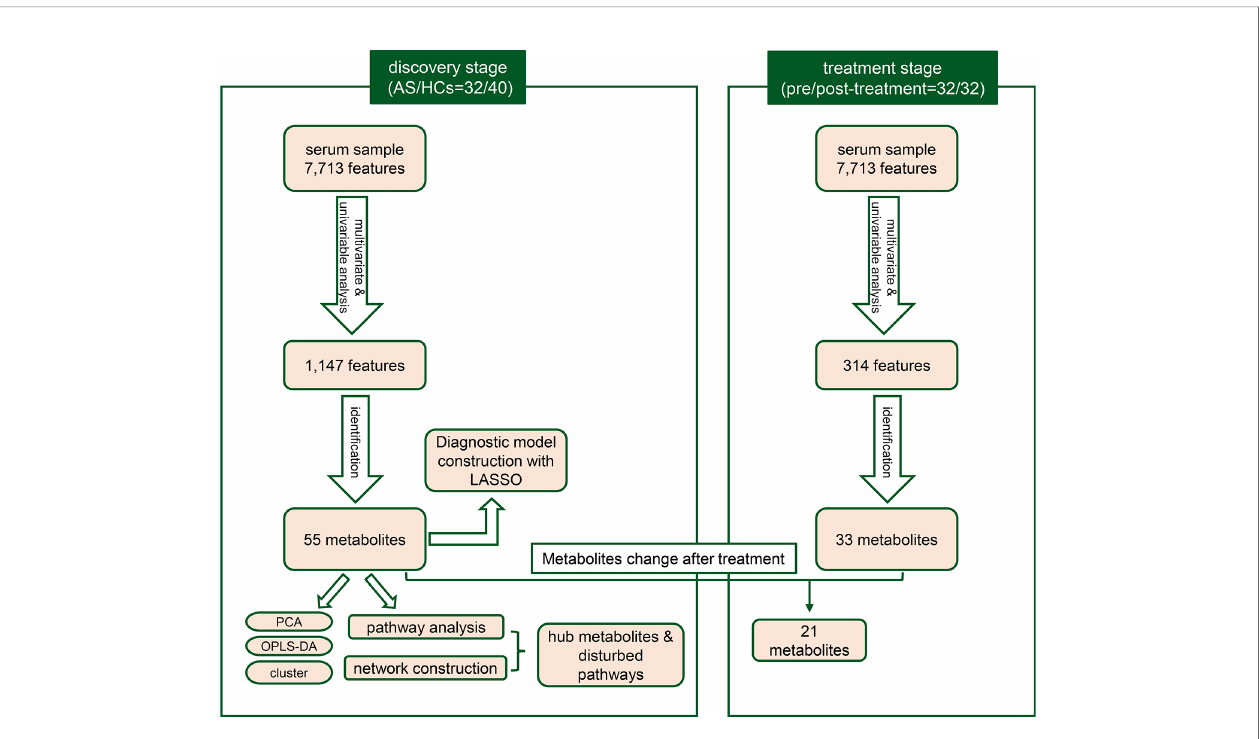
FIGURE 1 | The work fl ow for the study design and analytical